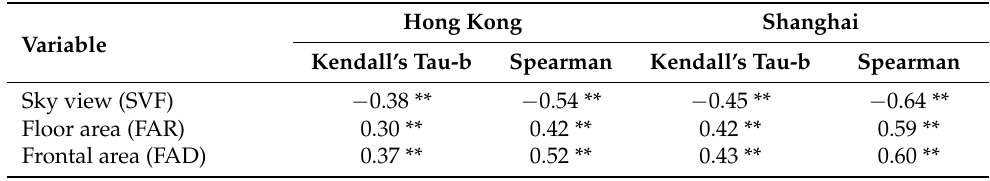
Table 2. Correlation coefficients between the selected built-environment features and COVID-19 risks for Hong Kong (HK) and Shanghai